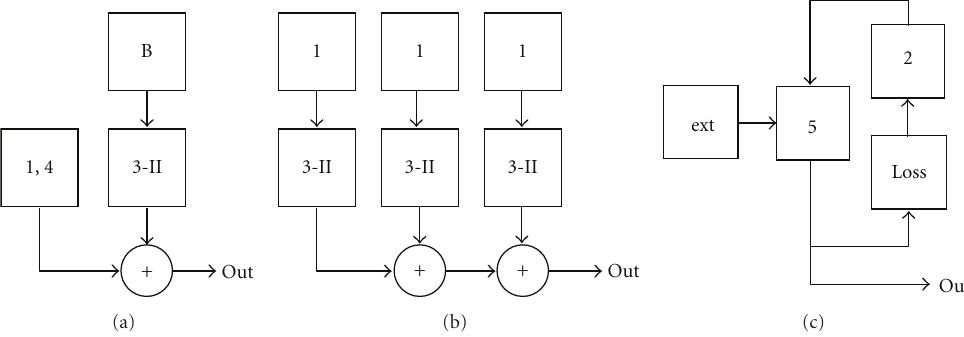
Figure 20: FBAM algorithms for (a) subtractive, (b) formant, and (c) abstract physical modeling sound synthesis arrangements. Variation numbers are given inside the operator boxes (B denotes the basic FBAM